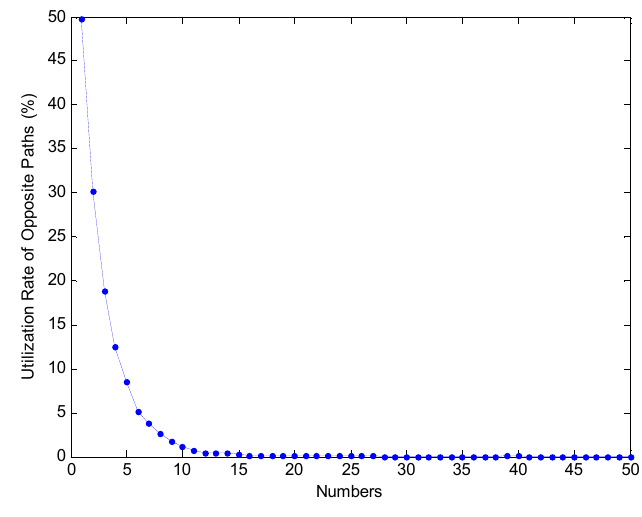
Figure 8. Utilization rate of opposite paths of COOBBO